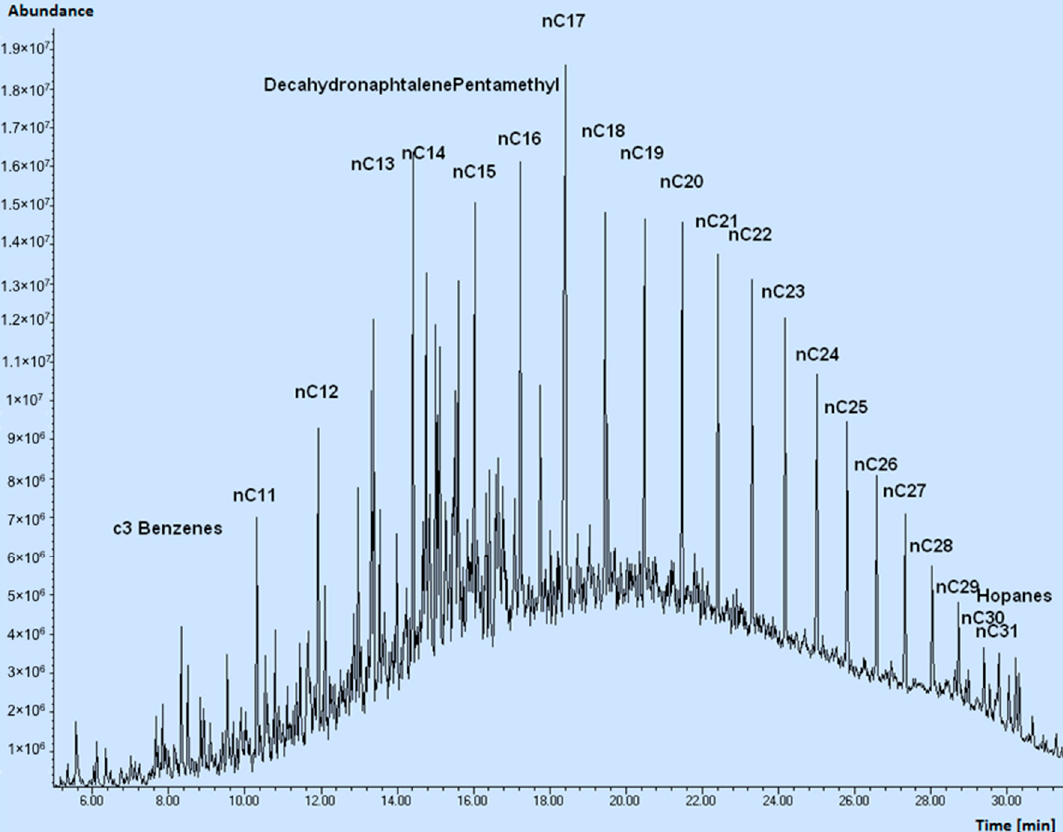
Figure 3. Total ion current chromatogram (GC-MS analysis) of the oil.